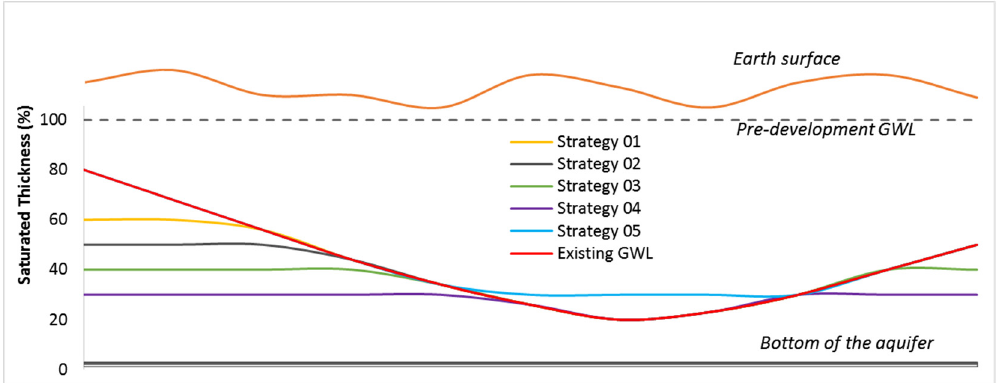
Figure 11. Schematic representation of abstraction strategies.